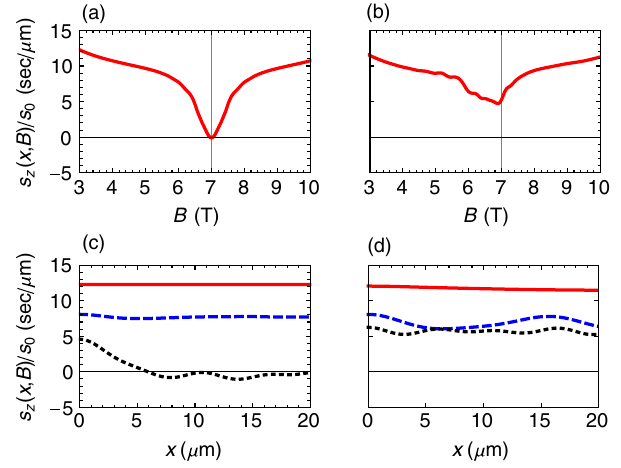
FIG. 8. The same as Fig. 5 but with an effective spin injector size of 2 μ m, 4 times larger than 0 . 5 μ m used in Fig. 5. In this case, the effective injector size is comparable to the typical channel width W ¼ 1 . 2 μ m. The dip in spin polarization is more pronounced for parabolic lateral confinement (a) as the resonance condition, Eq. (21), can be satisfied for all bands simultaneously, which is not the case for the infinite square-well confinement (b). This is due to the washing out of an oscillatory precessing polarization component with distance. The suppression of oscil- lations occurs for larger injector sizes and is present for both the parabolic (c) and square-well (d)